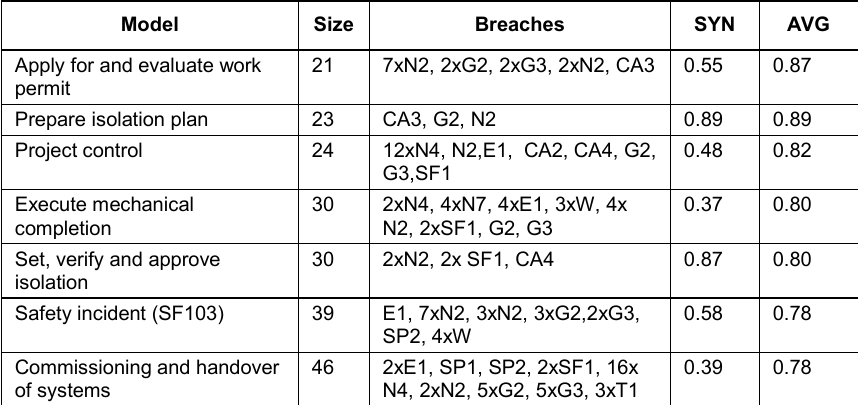
Table 2. Syntactic quality